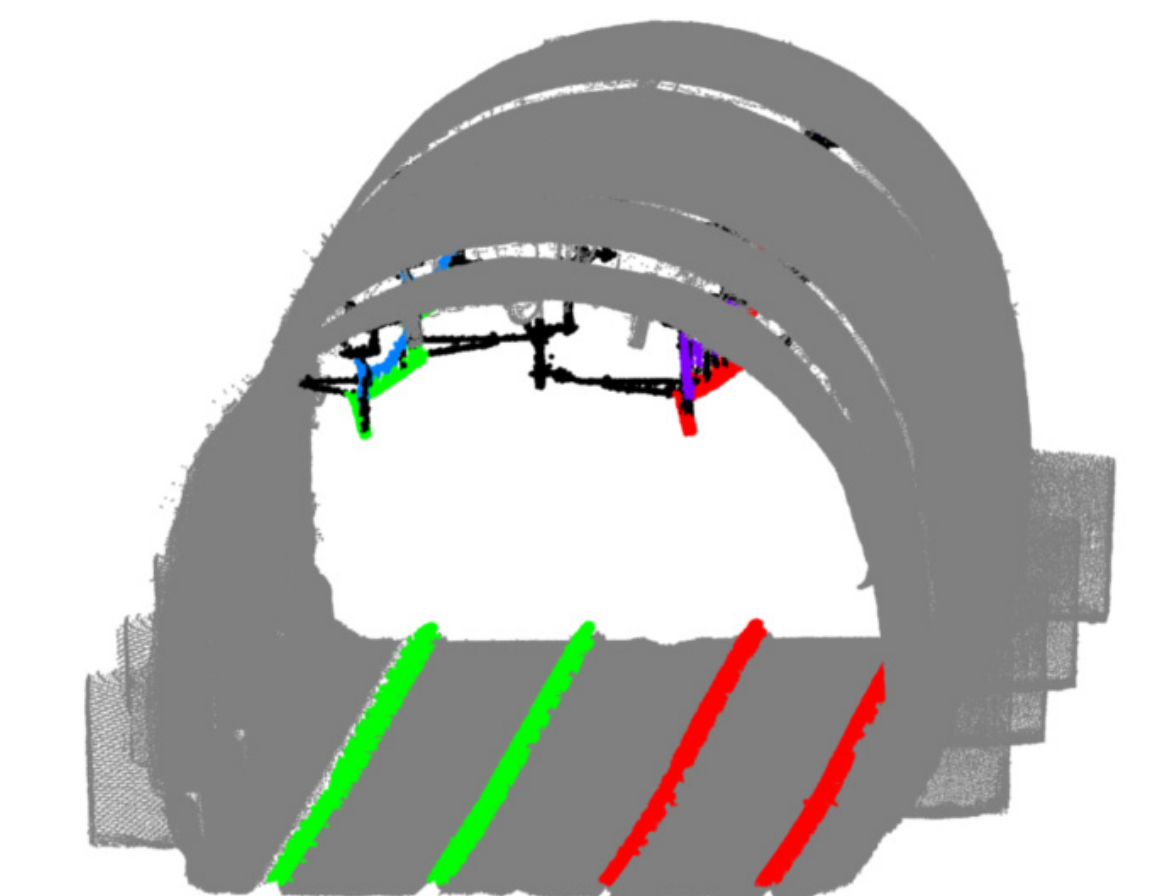
Figure A4. Railway segmentation in a tunnel: each contact wire has a different colour (green and red), matched by its correspondent rail. Each catenary has also a random colour.